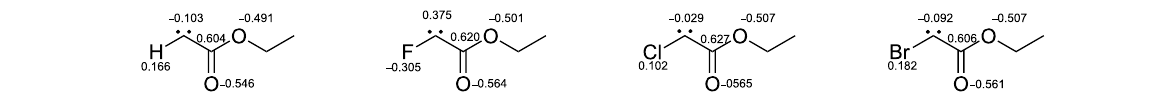
Figure 6: NBO atomic charges of the singlet carbenes from 1 and 2a , b , and d .